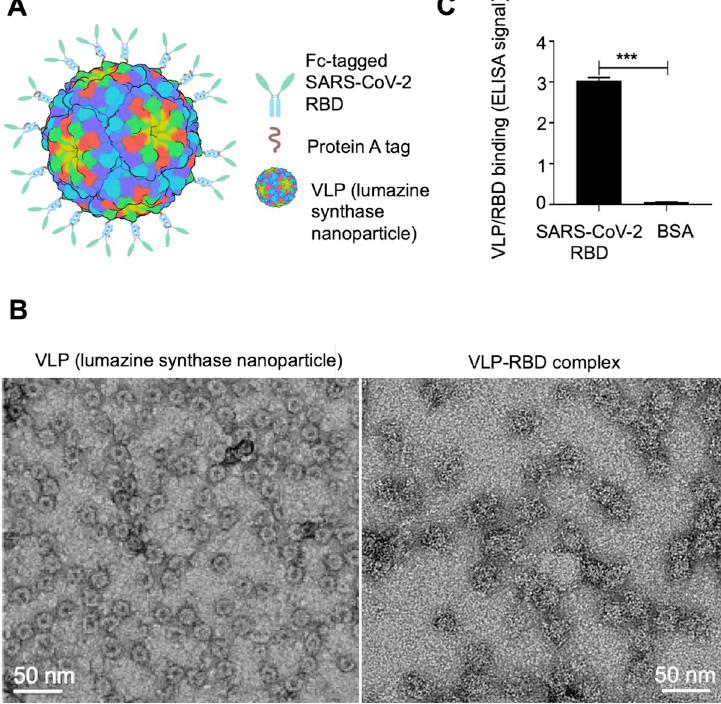
Fig 1. Design, construction and characterization of VLP-based SARS-CoV-2 RBD vaccine. (A) Schematic representation of Fc-tagged (light blue) SARS-CoV-2 RBD (light green), N-terminal protein A tag of nanoparticle (brown), and 60-meric VLP nanoparticle formed by bacterial lumazine synthase (colorful sphere). (B) Negative-stain EM analysis of VLP (left) and VLP-RBD complex (right). (C) Binding of VLP to SARS-CoV-2 RBD as detected using ELISA. SARS-CoV-2 RBD or equal amounts of bovine serum albumin (negative control) were coated on ELISA plate, and VLP (containing N-terminal His tag and protein A tag) was added later. Binding of VLP to RBD was detected by anti-His tag antibody. The data are presented as mean ± SEM (n = 12). A Student’s two-tailed t -test was performed to analyze the statistical difference between the groups. ��� p < 0.001. Experiments were repeated twice with similar